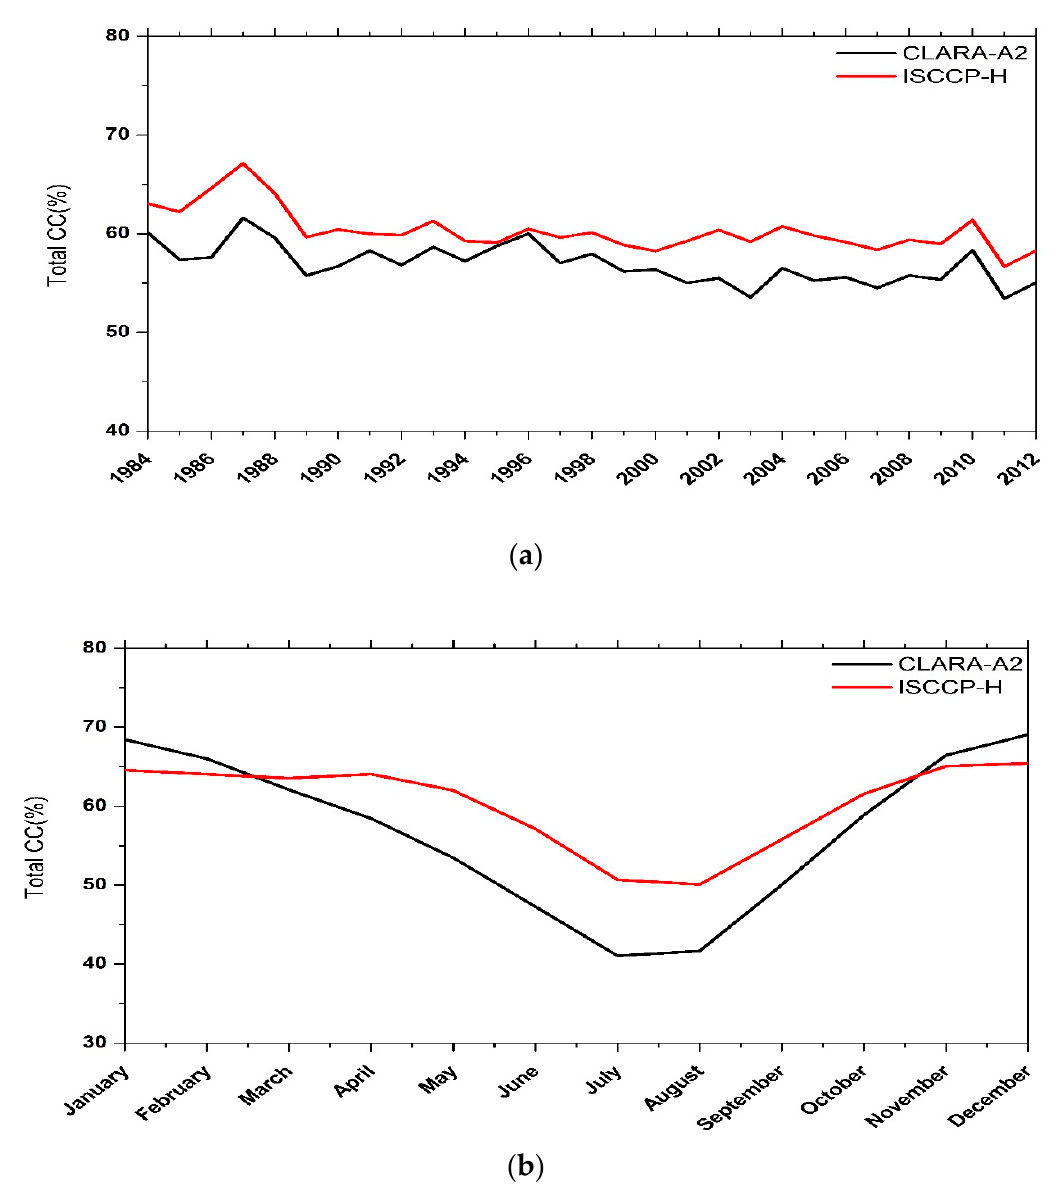
Figure 3 . ( a ) Time series of the mean annual TCC and ( b ) average seasonal variation of TCC from ISCCP-H and CLARA-A2 over the domain shown in Figure 2 for their common period (1984–2012).